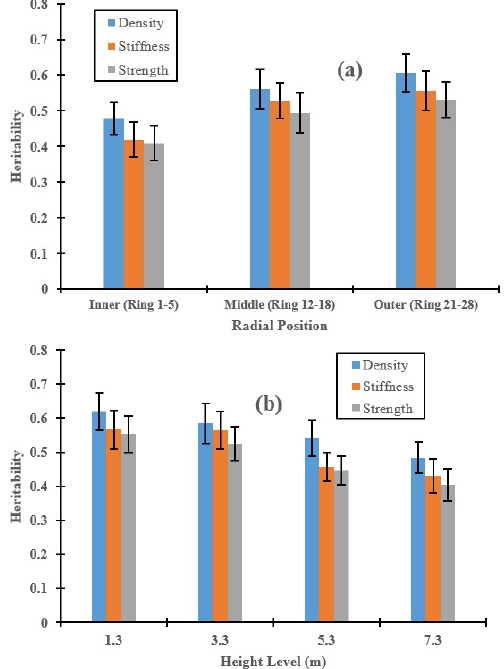
Figure 1. Radial ( a ) and axial ( b ) genetic control of wood density, stiffness and strength.